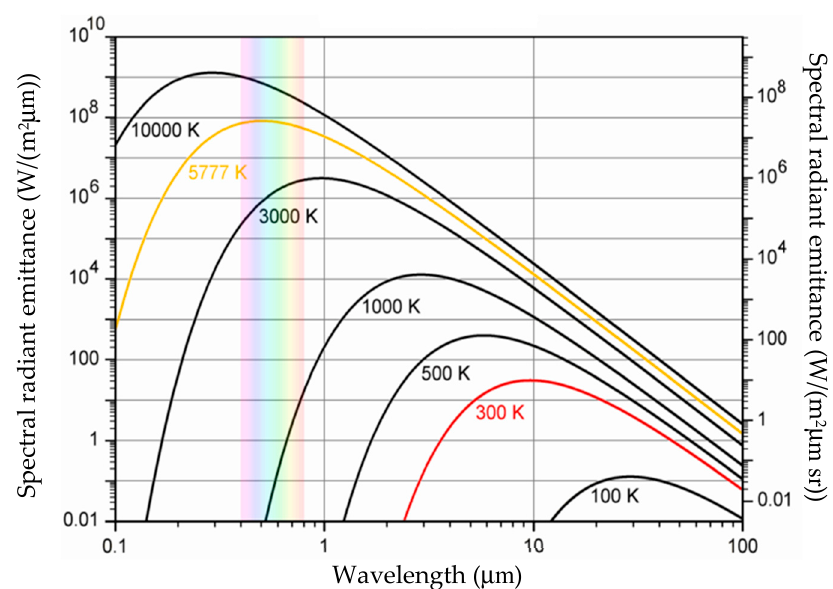
Figure 12. Spectral radiance of an ideal black body at different temperatures [70].